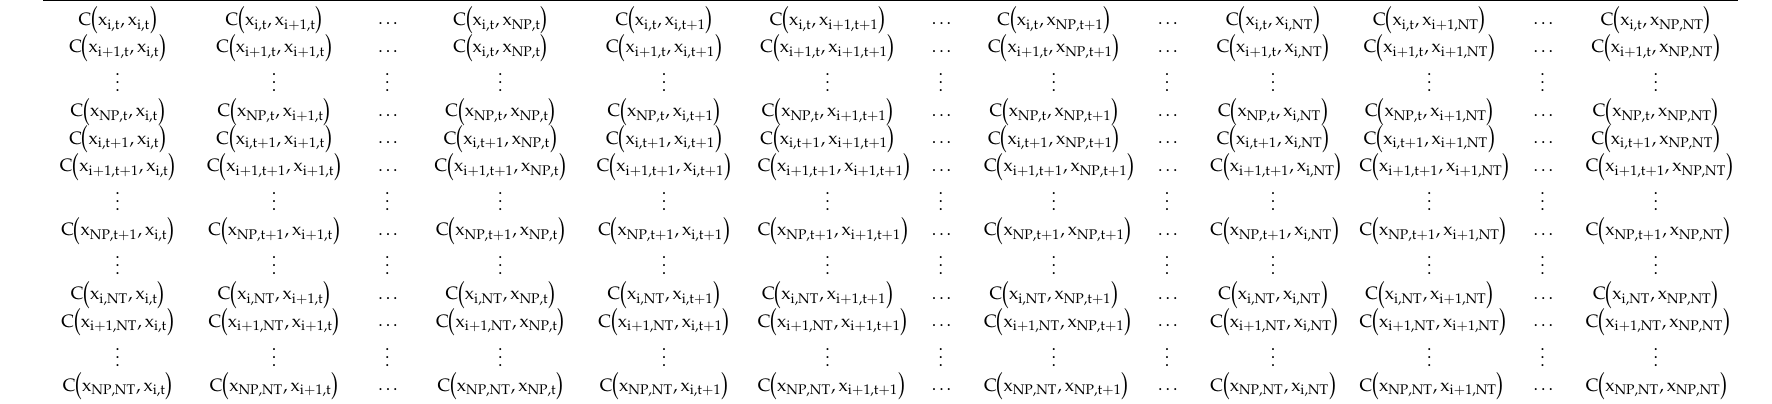
Table 3. Structure of the space–time covariance